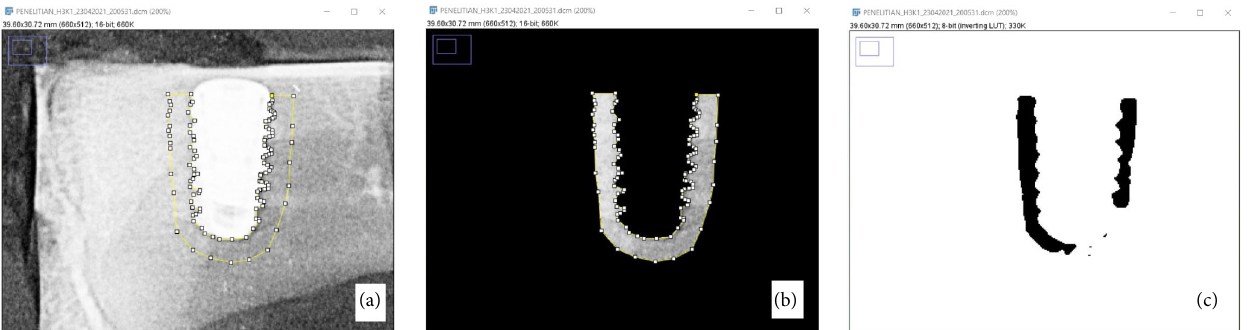
F IGURE 2: The density analysis and bone morphometry imaging process: (a) ROI selection on periapical radiographs; (b, c) digital processing on ImageJ cropping- fi lter Gaussian